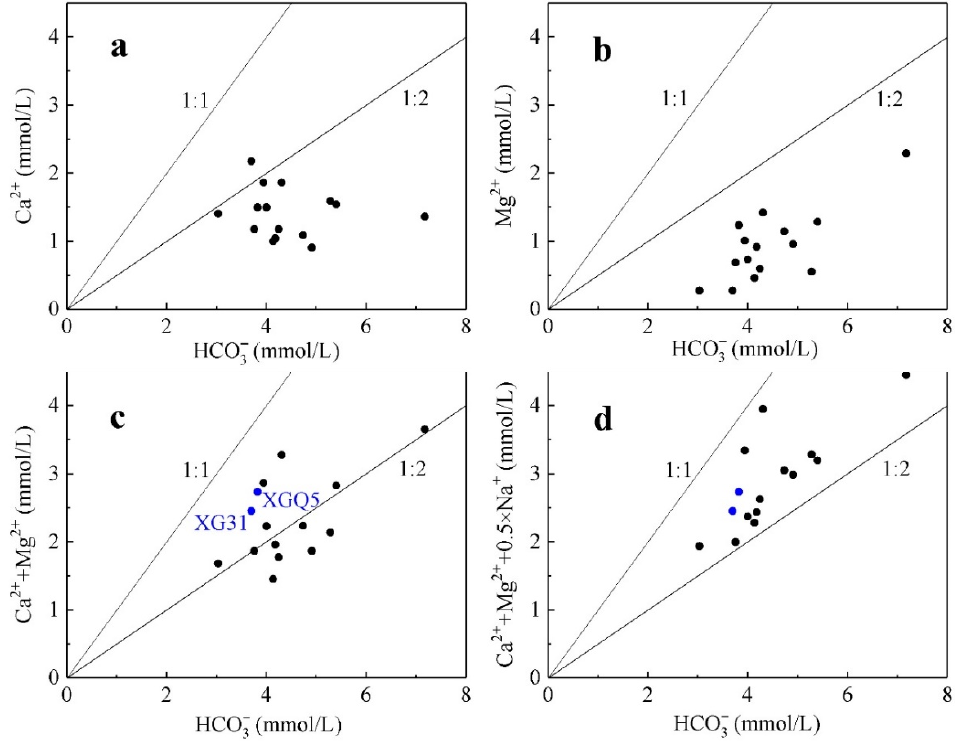
Figure 4. Proportion diagrams of ions.